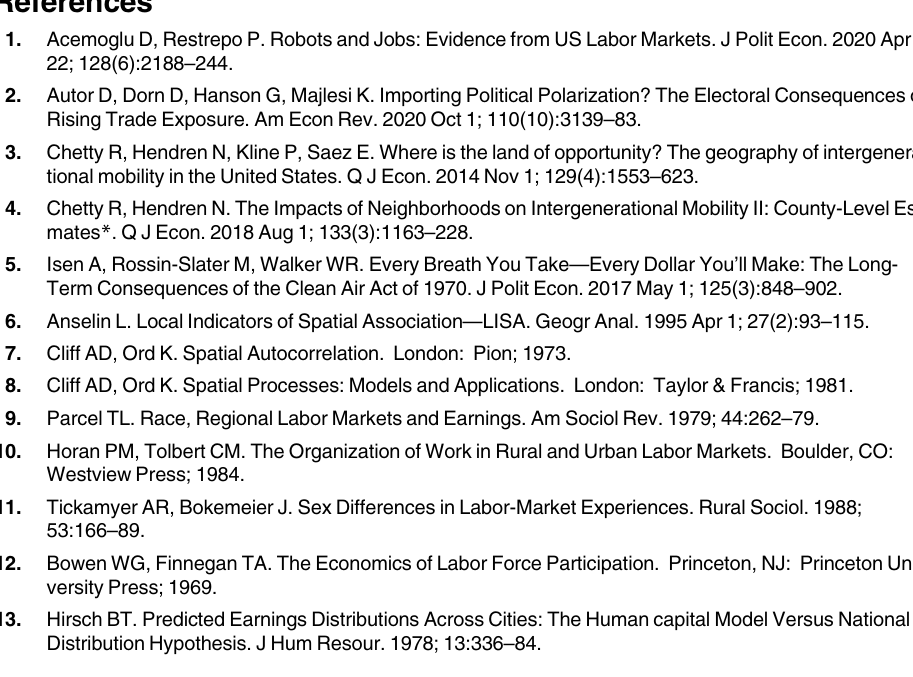
S7 Fig. LISA cluster map for economic variables (counties left, CZs right). S8 Fig. LISA cluster map for social variables (counties left, CZs right). S9 Fig. LISA cluster map for demographic variables (counties left, CZs